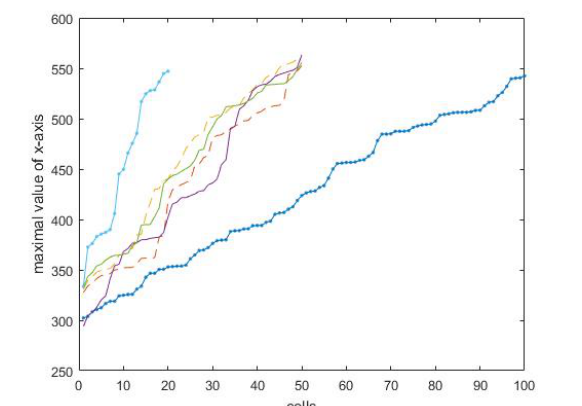
Fig. 21. X-axis distance profiles for different geometries and amounts of blood cells.